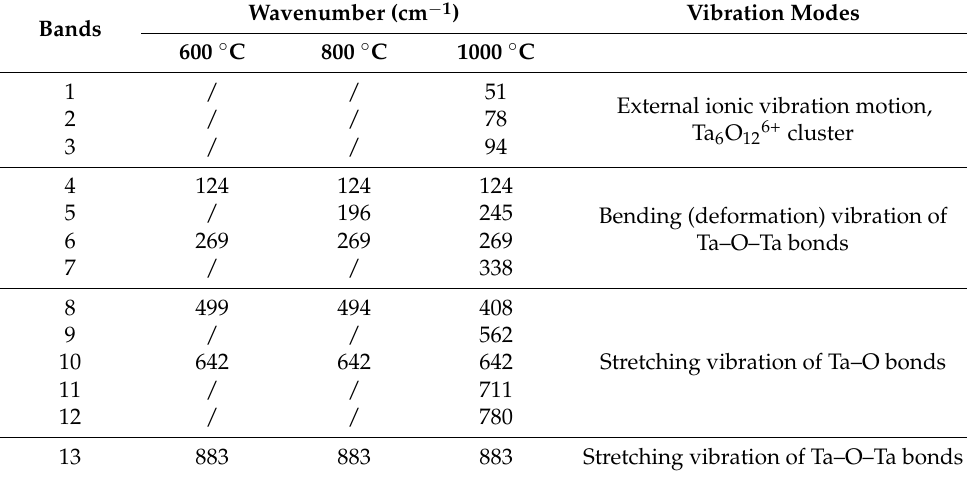
Table 1. Raman peak parameters from the deconvolution of the Raman spectrum of the samples.